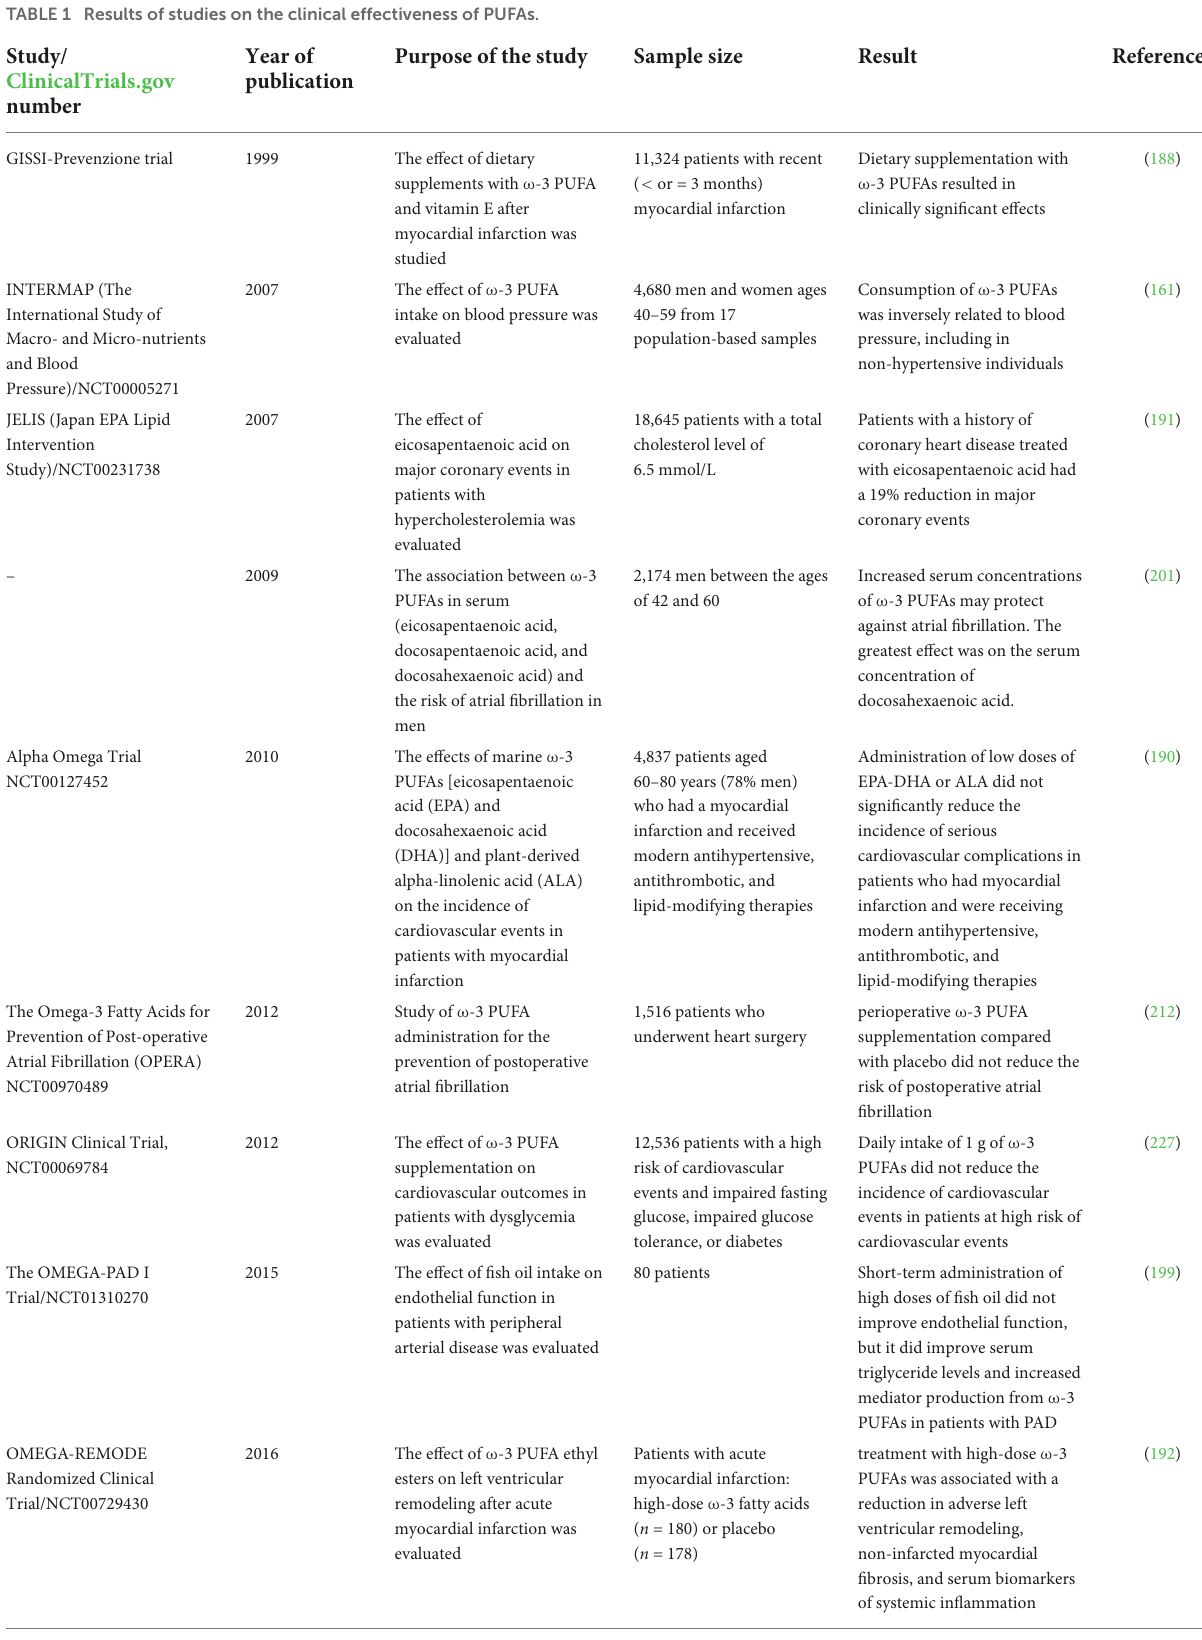
TABLE 1 Results of studies on the clinical effectiveness of PUFAs. Study/